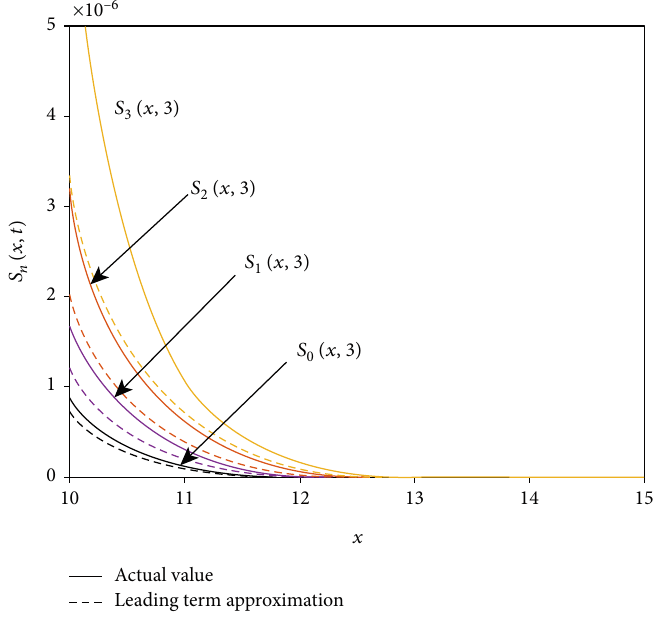
Figure 6: Leading term approximation for x ⟶ + ∞